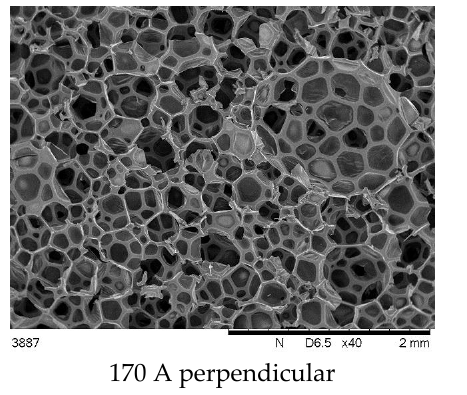
Figure 3. SEM cross-sectional images of foams synthesized at 110 bar, taken perpendicular and parallel to the growth direction.